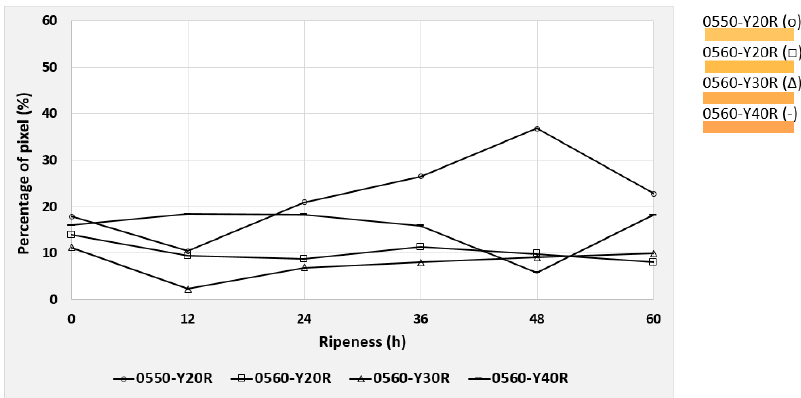
Figure 13. Development of the six most dominating peel colors of cv. “Mahachanok” mangos during the 70 h post-ripening process, depicted as NCS color codes.